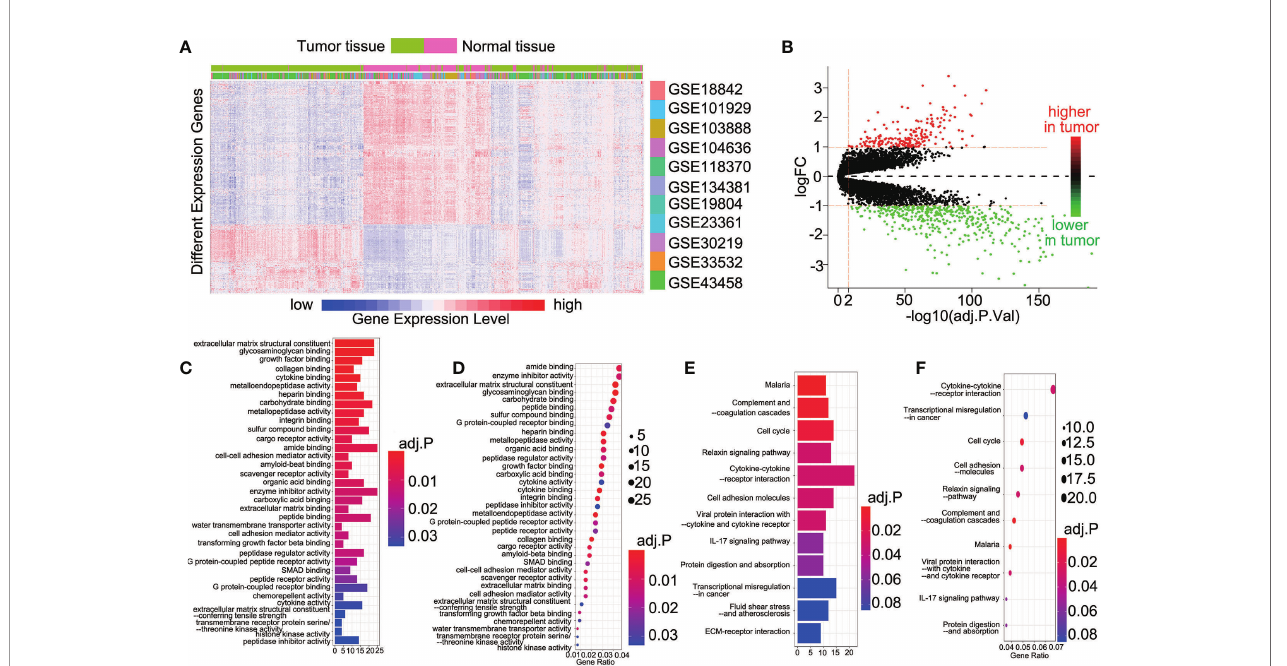
FIGURE 1 | 613 DEGs were identi fi ed in 11 datasets. (A) Heatmap showed the expression of genes between the tumor and control tissue samples; (B) Scatterplot showed the higher or lower DEGs between the tumor and control tissue samples; (C) The Go analyses of higher DEGs; (D) The KEGG analyses of higher DEGs; (E) The Go analyses of lower DEGs; (F) The KEGG analyses of lower